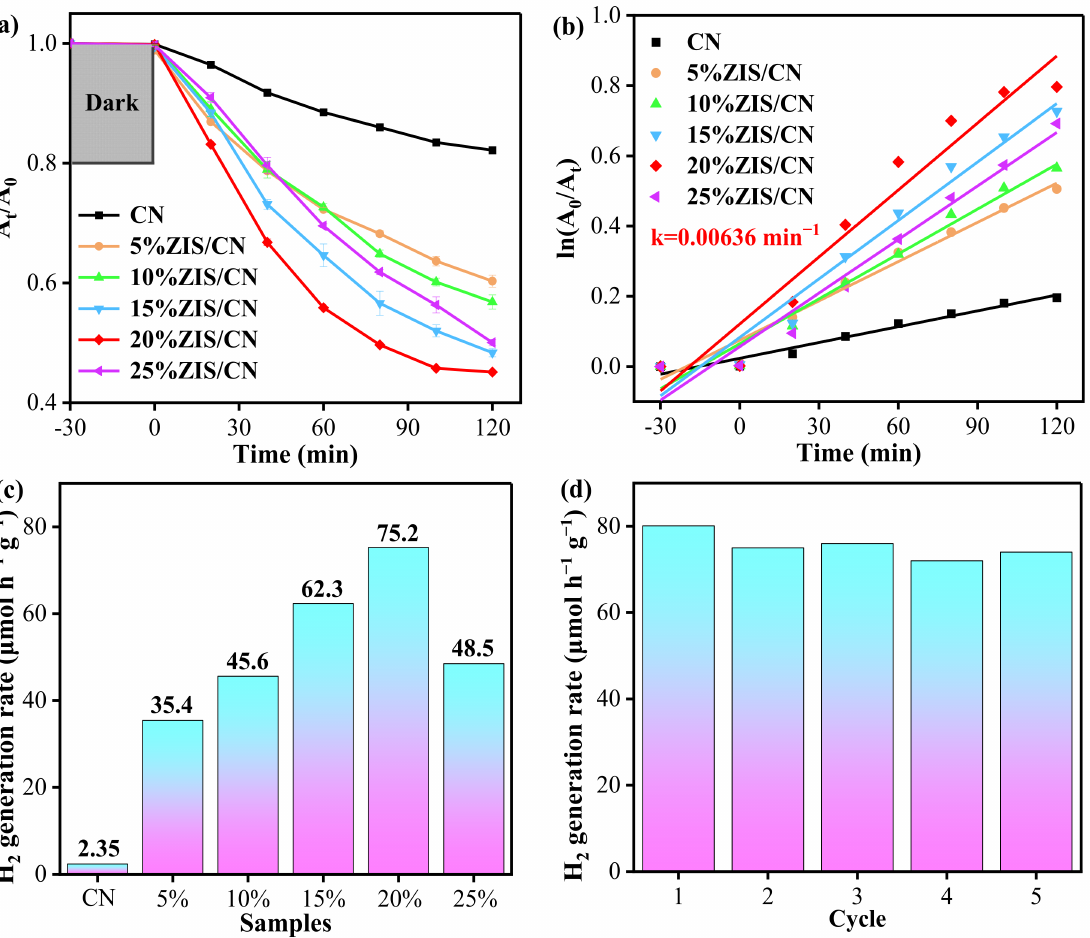
Figure 6. ( a ) TC degradation curve of CN and ZIS/CN composites; ( b ) kinetic curve of TC pho- todegradation; ( c ) hydrogen production rates; ( d ) recycling test of the photocatalytic hydrogen generation over